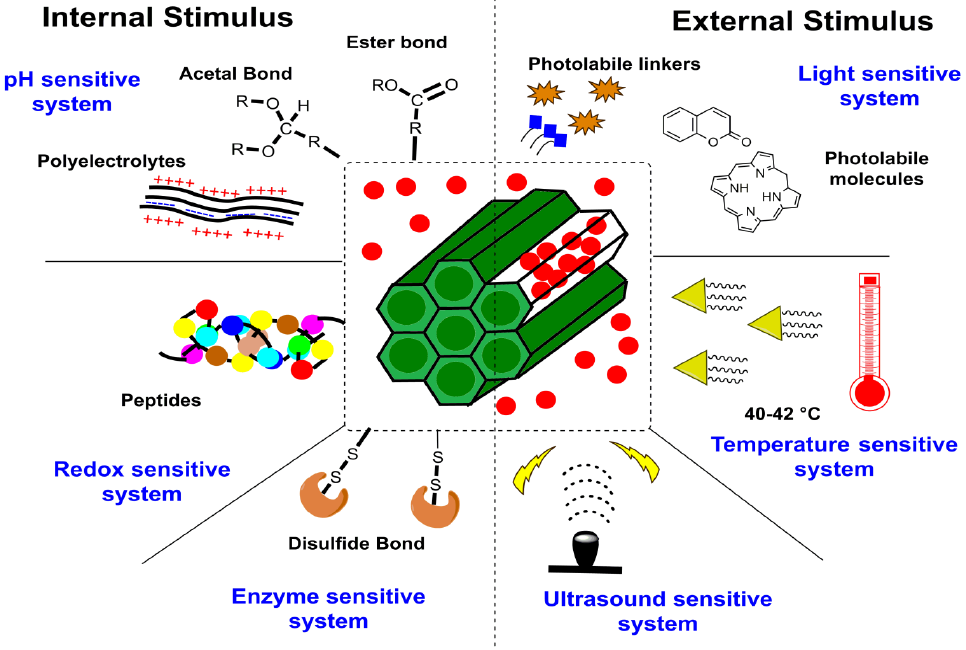
Figure 11. Different stimuli-based gatekeepers that keep the drug guarded inside the mesoporous silica nanoparticles and trigger an on-demand release.